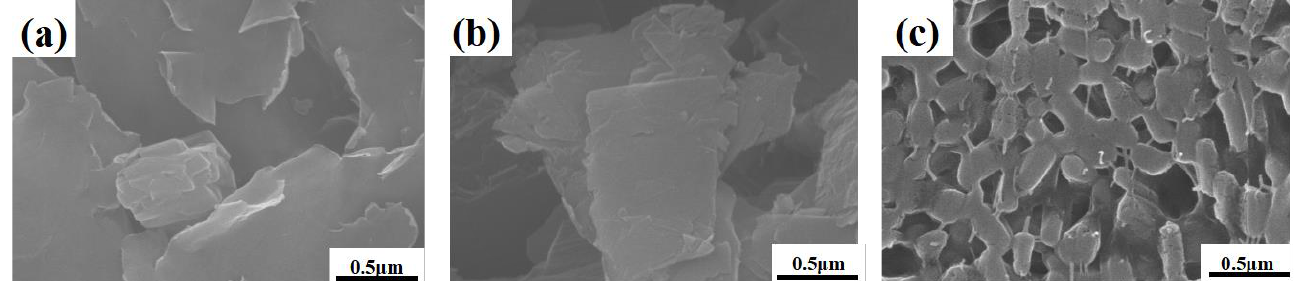
Figure 1. SEM images of ( a ) OMMT, ( b ) EGR, ( c ) PTFE.